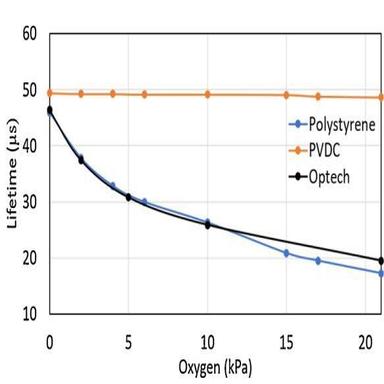
Lifetime response to O2 partial pressure for the polystyrene, PVDC and Optech (Mocon) sensors/coatings at 25 °C.